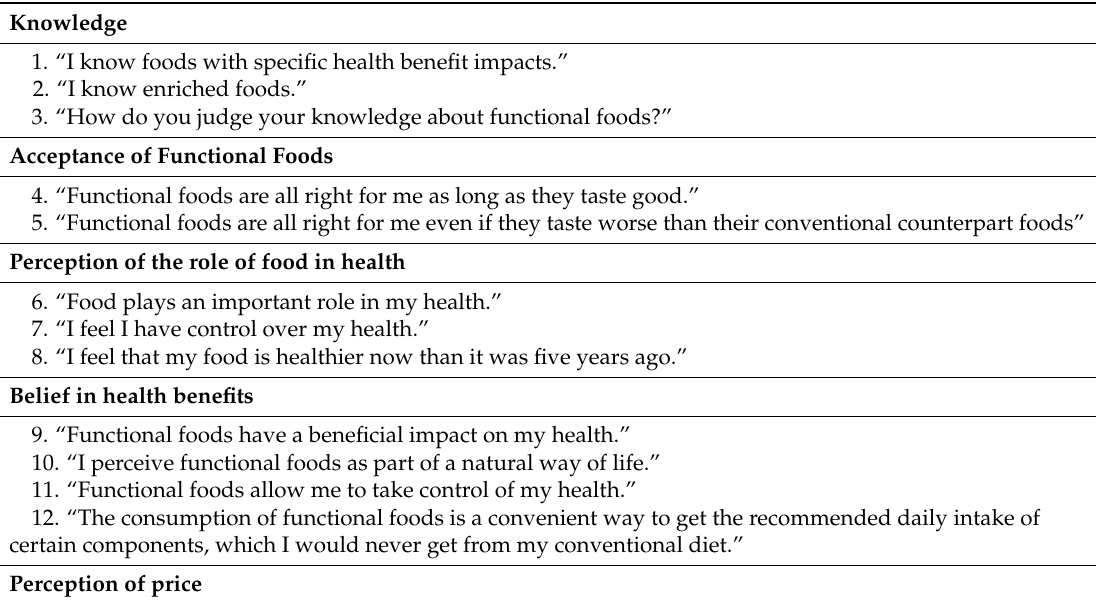
Table 1. Items addressed in the instrument for assessing the impact of cognitive and attitudinal determinants on the acceptance of functional